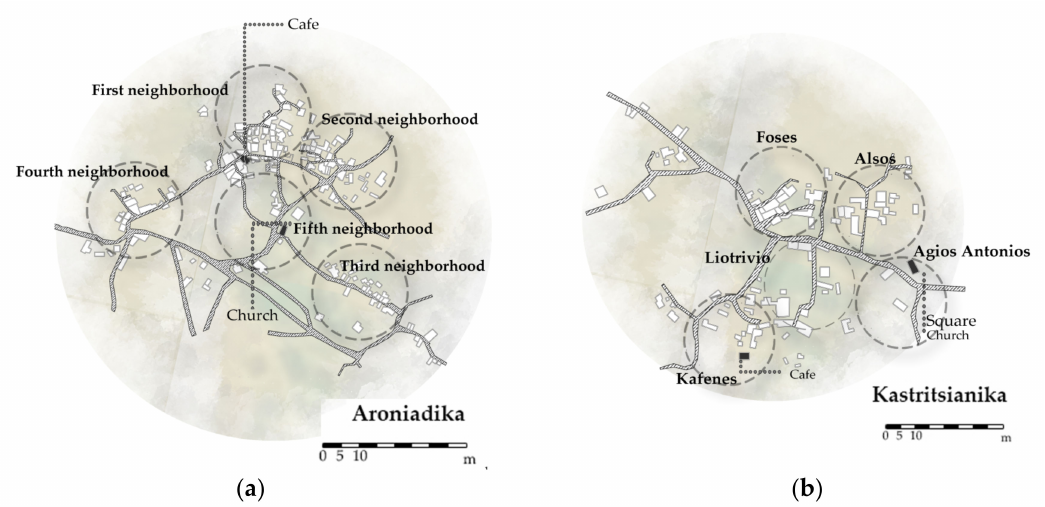
Figure 6. Spatial organization of ( a ) Aroniadika and ( b ) Kastritsianika.